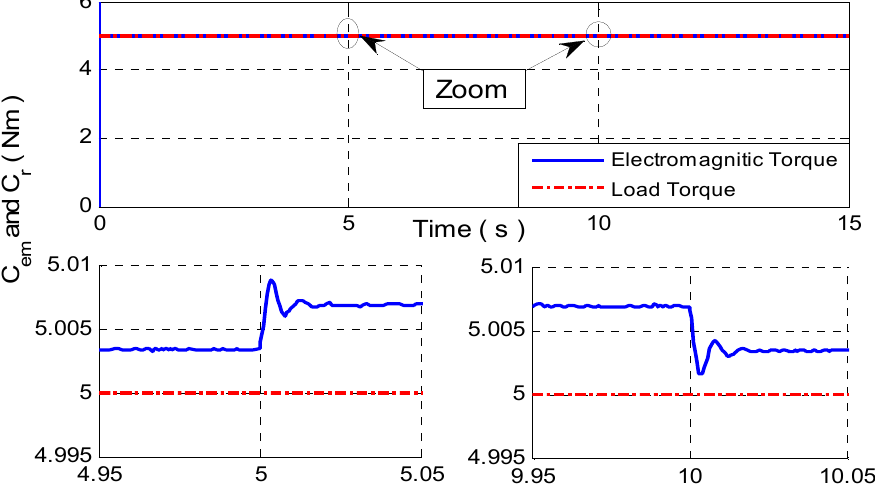
4.95 Figure 12. Load torque and electromagnetic torque with zoom. Figure 12. Load torque and electromagnetic torque with zoom. Figure 13 represents the variation in the quadratic current i q , which leads to an increase in the power drops of the Figure 13 represents the variation in the quadratic current 𝑖 crease in the power drops of the SP ‐ PMSM.